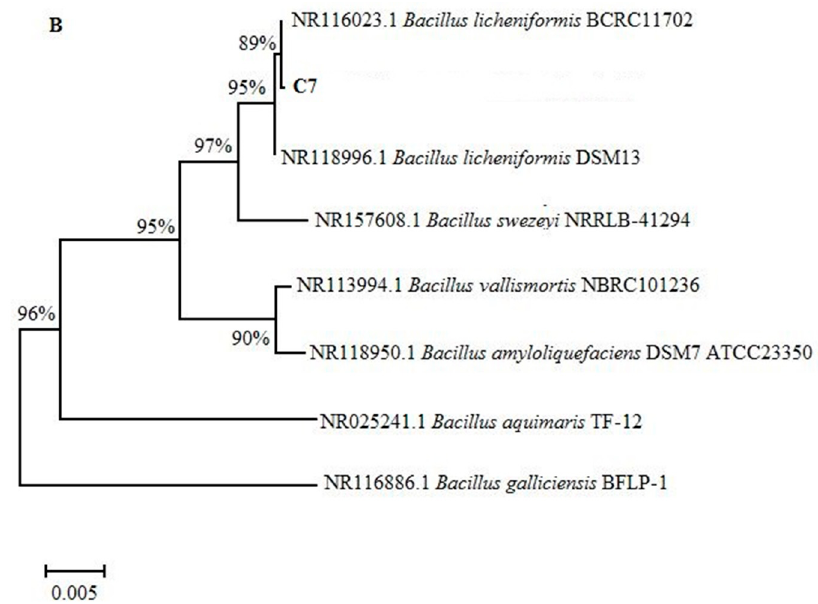
Figure 1. Phylogenetic tree showing the relationship among ( A ) Th4 and Th6 based on sequencing results of the ITS region and ( B ) C7 based on sequence results of the 16S rRNA gene.